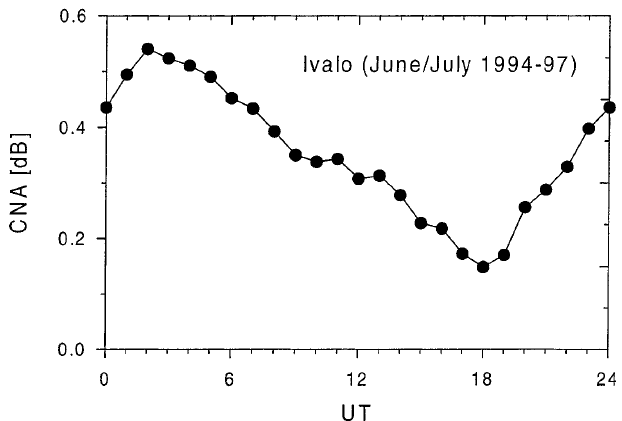
Fig. 5. Mean diurnal variation of cosmic noise absorption (CNA) at 29.9 MHz after observations during June and July 1994–1997 at Ivalo